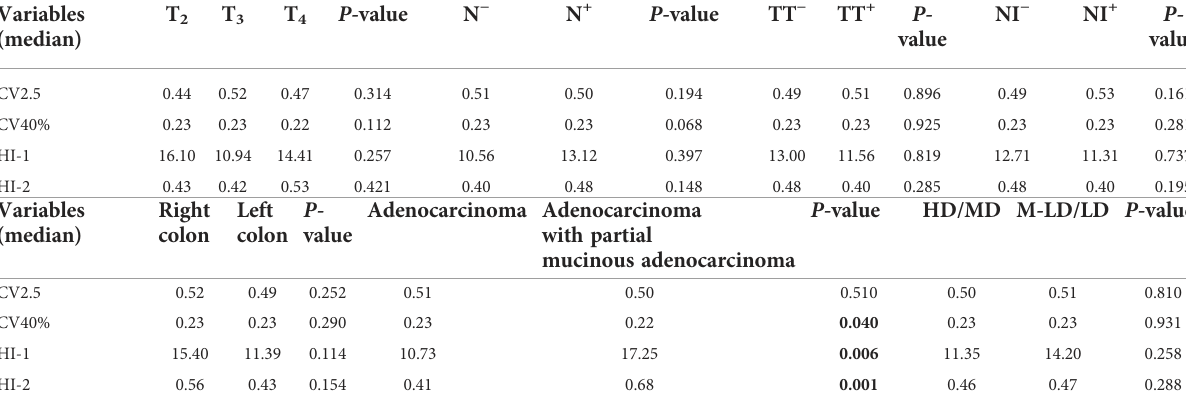
TABLE 3 Differences in 18 F-FDG PET/CT heterogeneous parameters between different pathological features. Variables